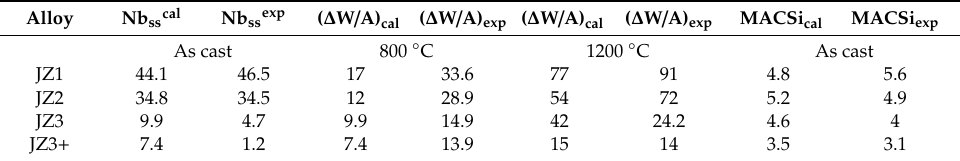
Table 8. Comparison of calculated and experimental vol.% Nb ss , weight changes ( ∆ W / A, mg / cm 2 ) at 800 and 1200 ◦ C and macrosegregation of Si (MACSi,